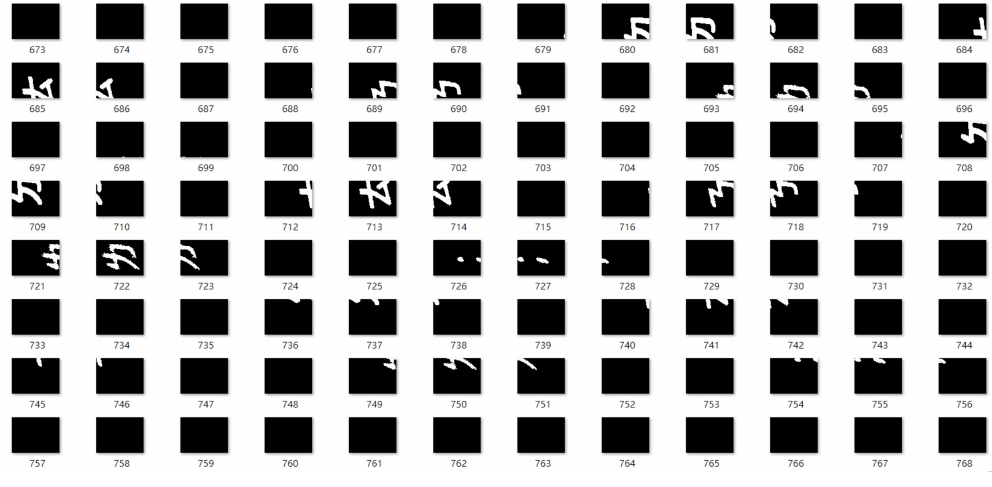
Figure 4. Part A of image